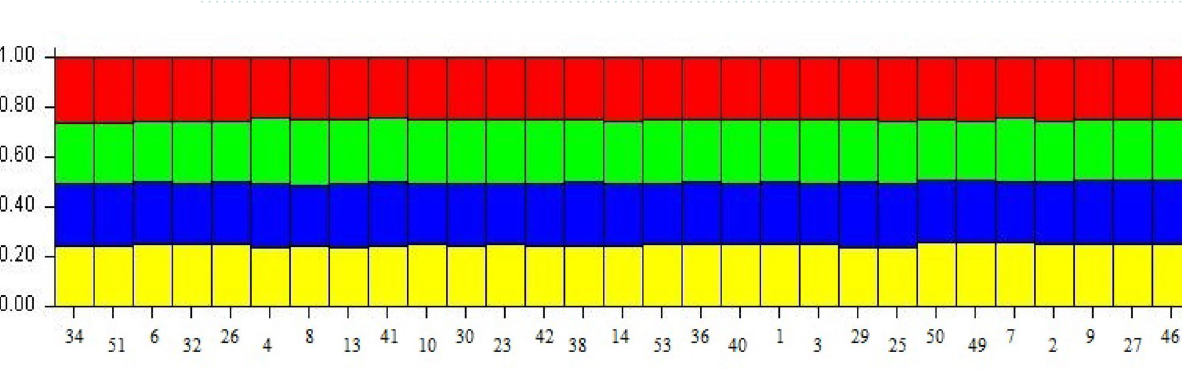
Figure 4. Genetic structure of genotypes according to SSR data ( Cucurbita pepo ) genotypes given in K = 4 are presented in Table